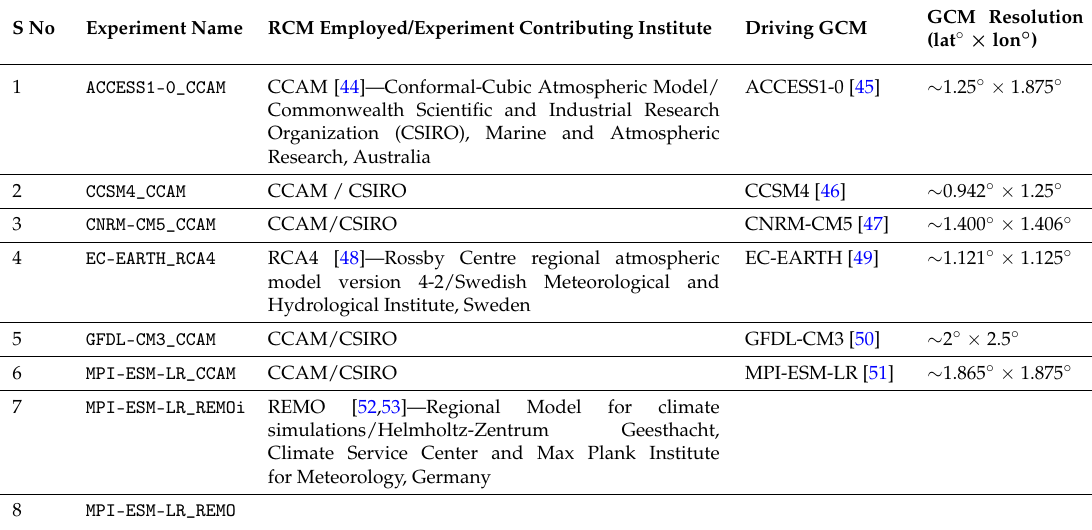
Table 1. The CX-SA and their driving CMIP5 experiments, employed RCM and contributing